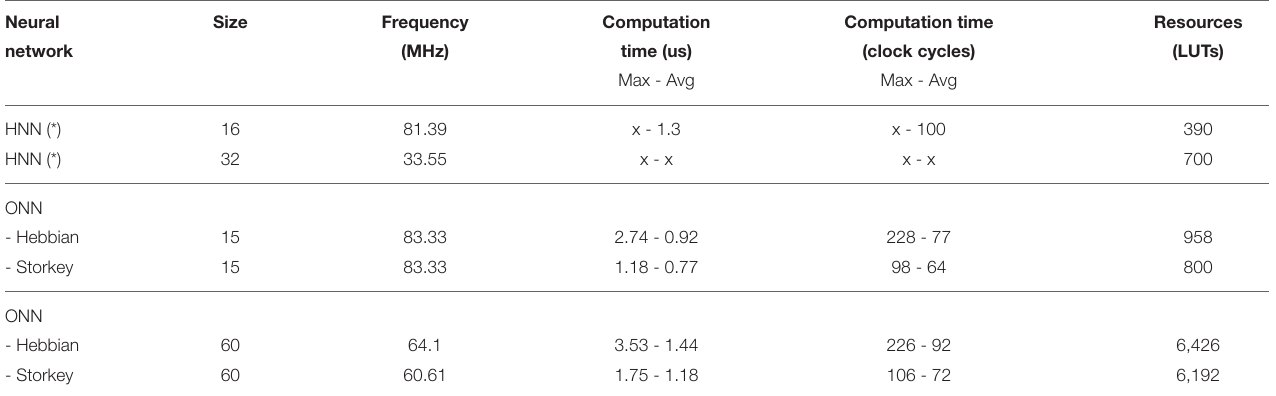
TABLE 6 | Frequency, computation time and resource comparison of ONN and HNN designs. Neural